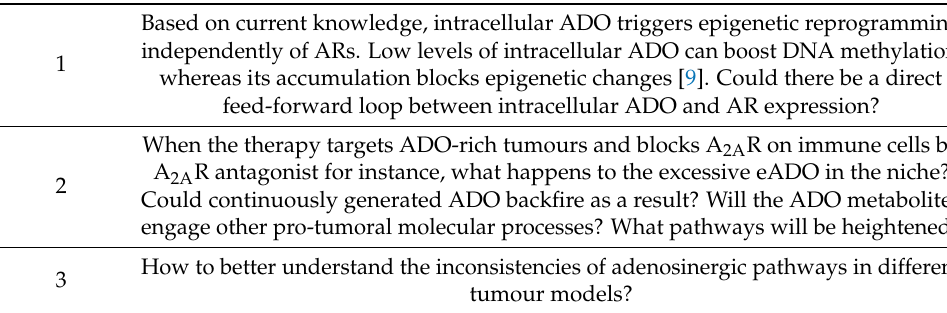
Table 2. Important questions about the adenosinergic